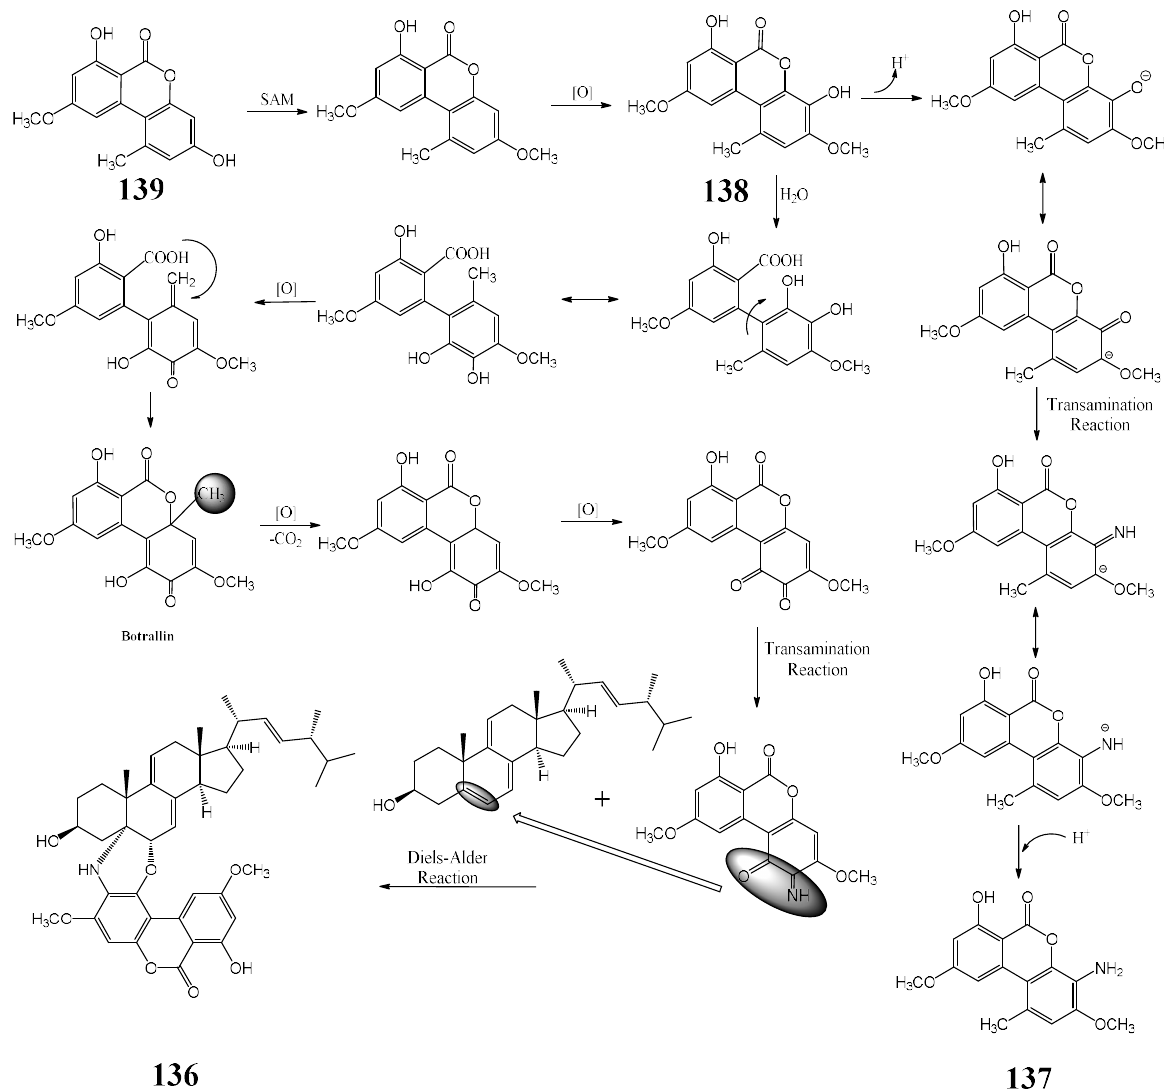
Figure 4. Plausible biogenetic correlation of pestauvicomorpholine A and three alternariol ana- logues [175].